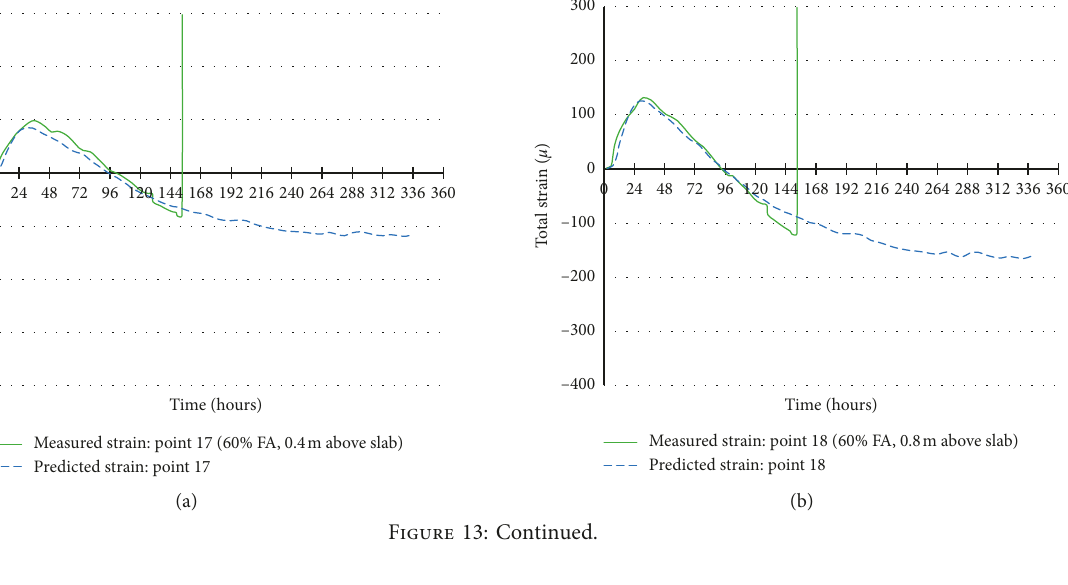
18–400 Measured strain: point 18 (60% FA, 0.8m above slab) Predicted strain: point